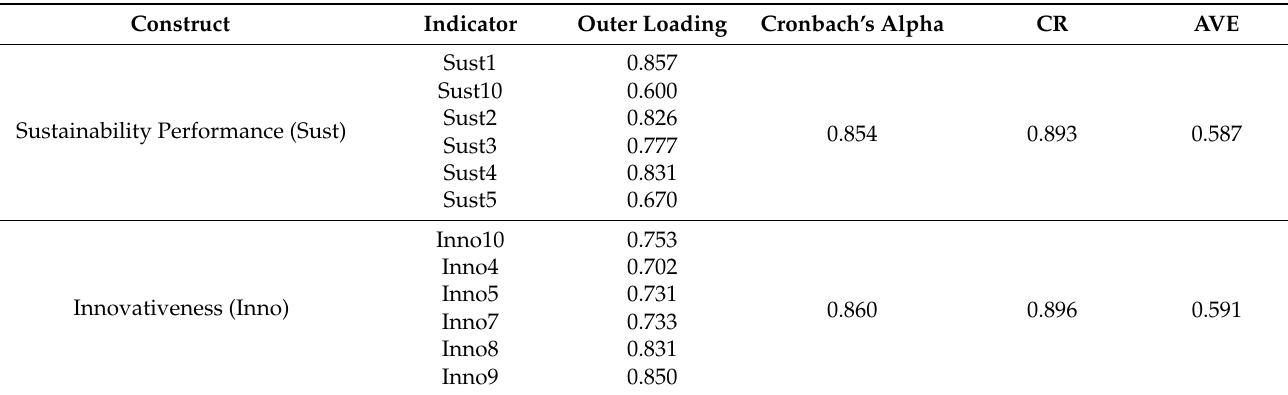
Table 2. Evaluation of the Measurement